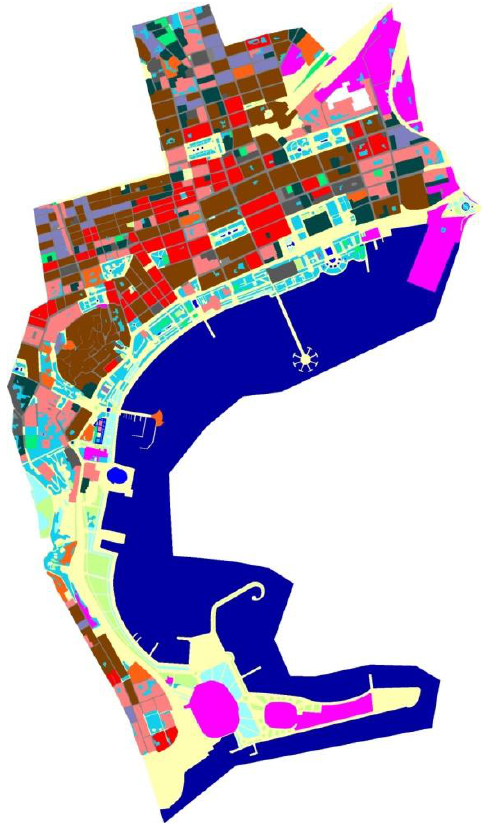
Figure 5. Clutter map scheme in Baku